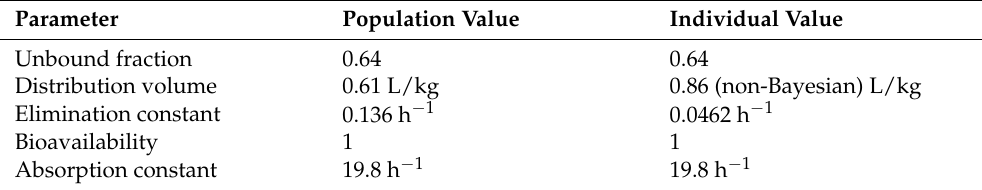
Figure 1. Caffeine blood concentration based on three caffeine blood samples extrapolated in a phar- macokinetic model using a therapeutic drug-management application. macokinetic model using a therapeutic drug-management application. Table 2. Pharmacokinetic parameters of caffeine blood concentration model. Table 2. Pharmacokinetic parameters of caffeine blood concentration